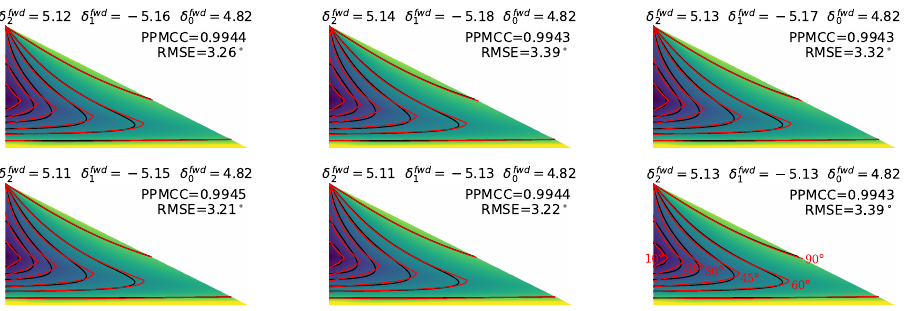
Figure 13. Distribution and contours (in red) of FWD–GCA metric for evaluating Collignon projection using rational function–based regression with different regression